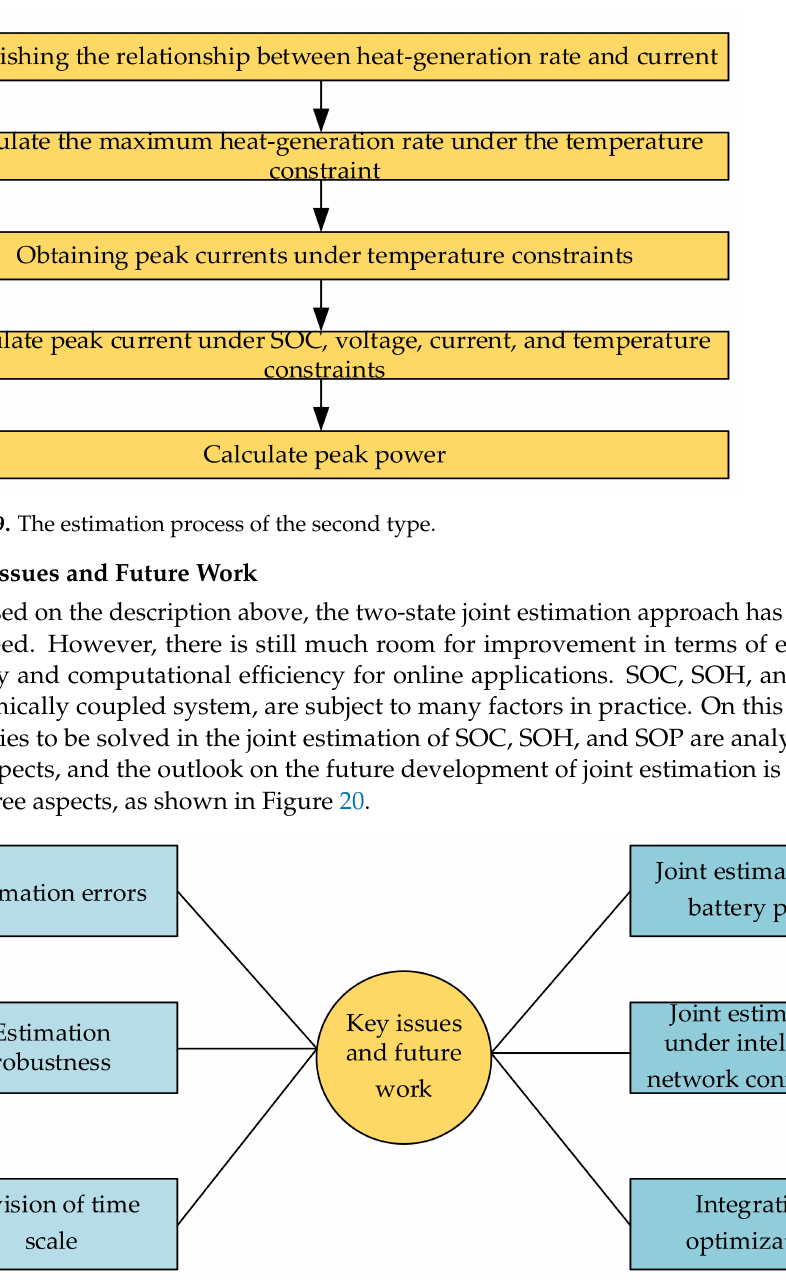
Figure 20. Key issues and future